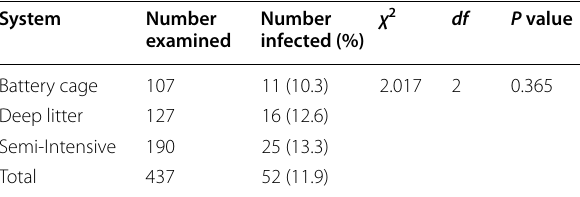
Table 4 The prevalence of Cryptosporidium oocysts according to system of bird